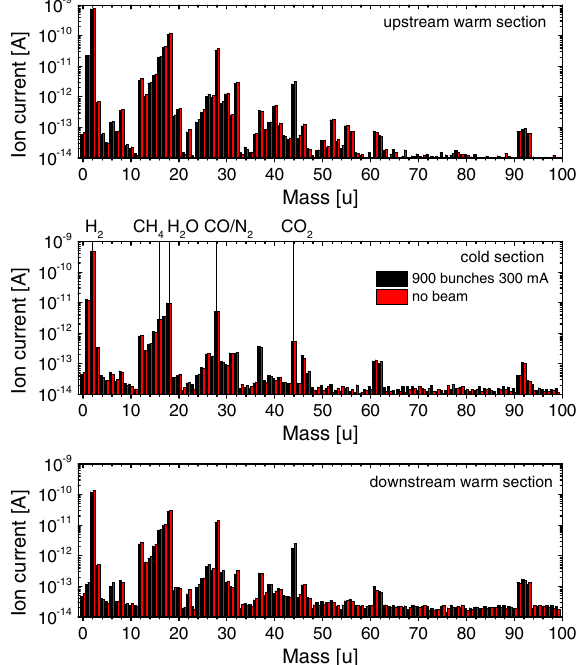
FIG. 8. Mass spectra of the residual gas in the three sections of COLDDIAG measured with the RGA in each diagnostic port. The measurements with and without beam are 40 minutes apart. Reproducibility of the peak ratio: 0.5%, detection limit: 1 × 10 − 14 mbar